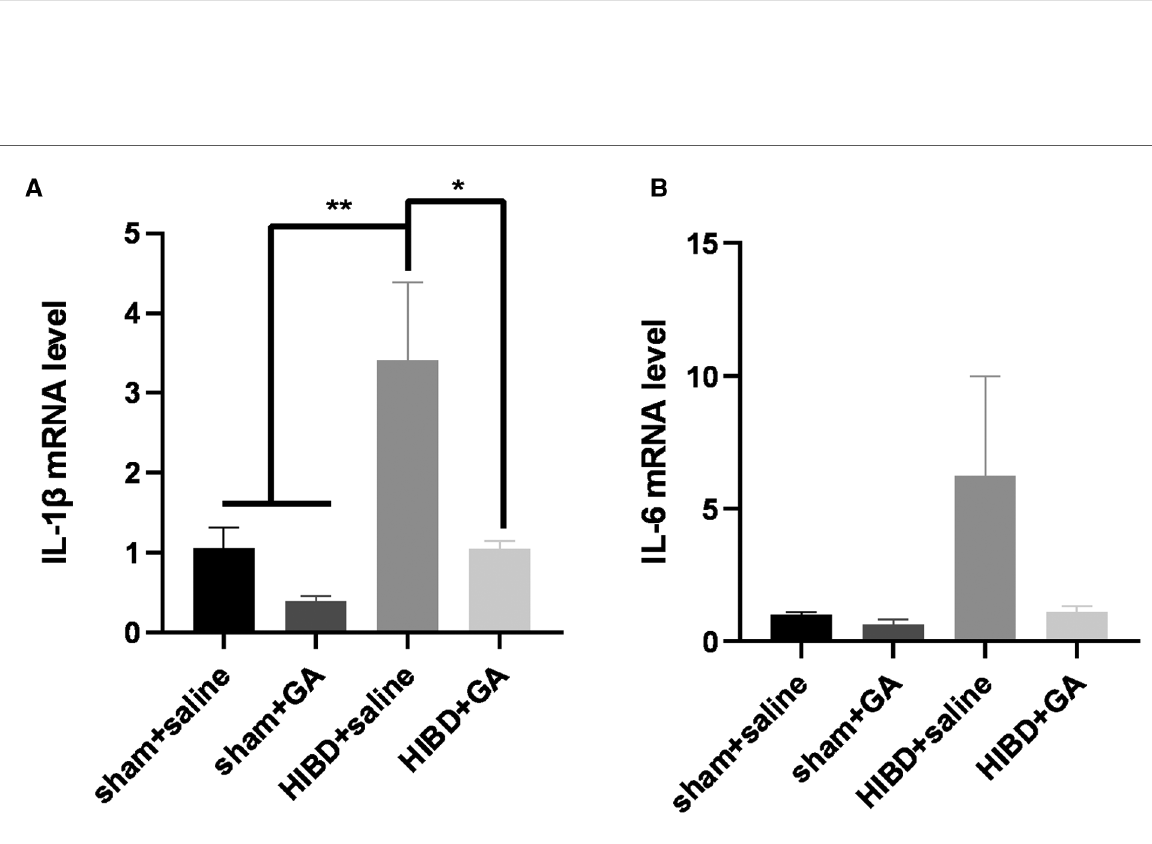
FIGURE 4 Ga decreases the neuroin fl ammation in HIBD rats. The rats were sacri fi ced 48 h after modeling, and RNA was extracted to detect the expression of proin fl ammatory cytokines. The increased mRNA levels of IL-1 β (A) and IL-6 (B) in HIBD rats were rescued with GA treatment ( n =3). Data are presented as mean±SEM. * P